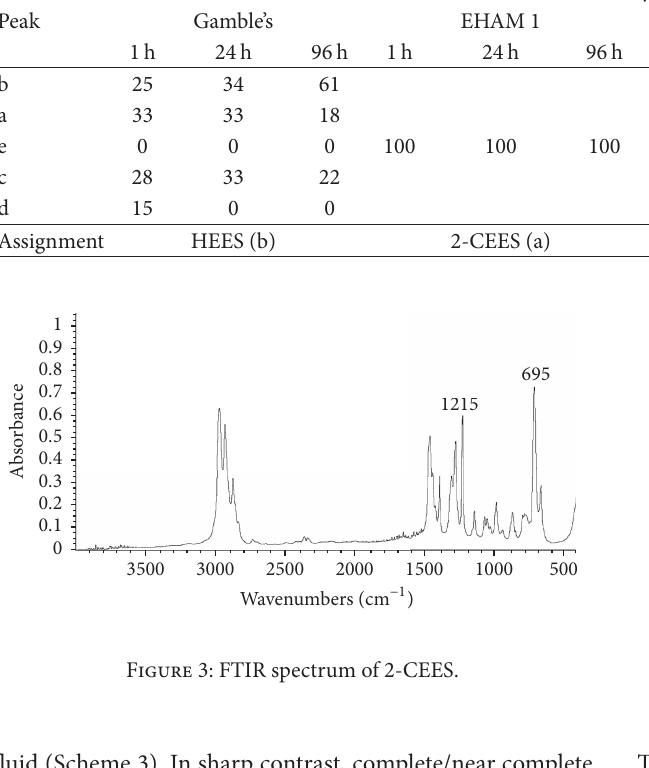
F 2: (a) Fate of DFP in �uids, (b) fate of DFP in Gamble’s �uid with EHAMs. T 4: Comparison of methyl-peak intensities of 2-CEES reaction products. Relative intensity percentage